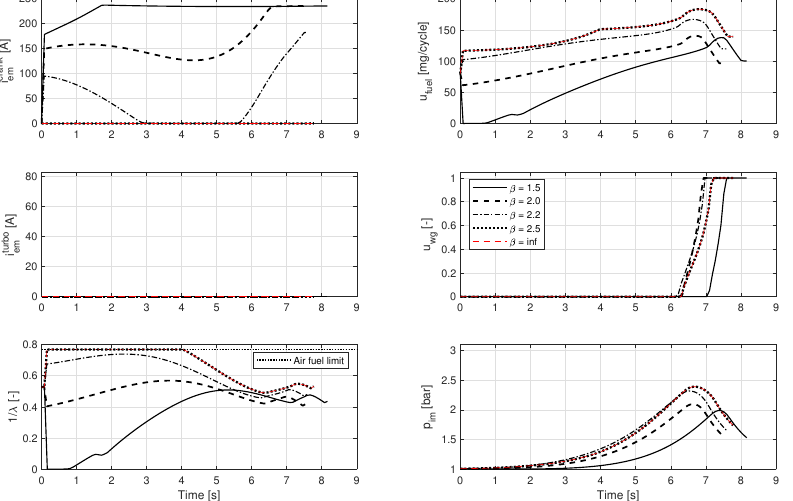
Figure 10. Controls, fuel-air ratio and intake manifold pressure during the acceleration when the E-crank is used to support the